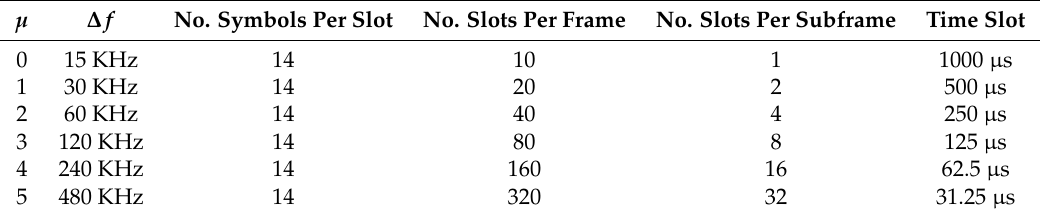
Table 1. NR numerology, Subcarrier Spacing, Number of OFDM symbols per slot, Number of slots per frame, Number of slots per subframe and Time